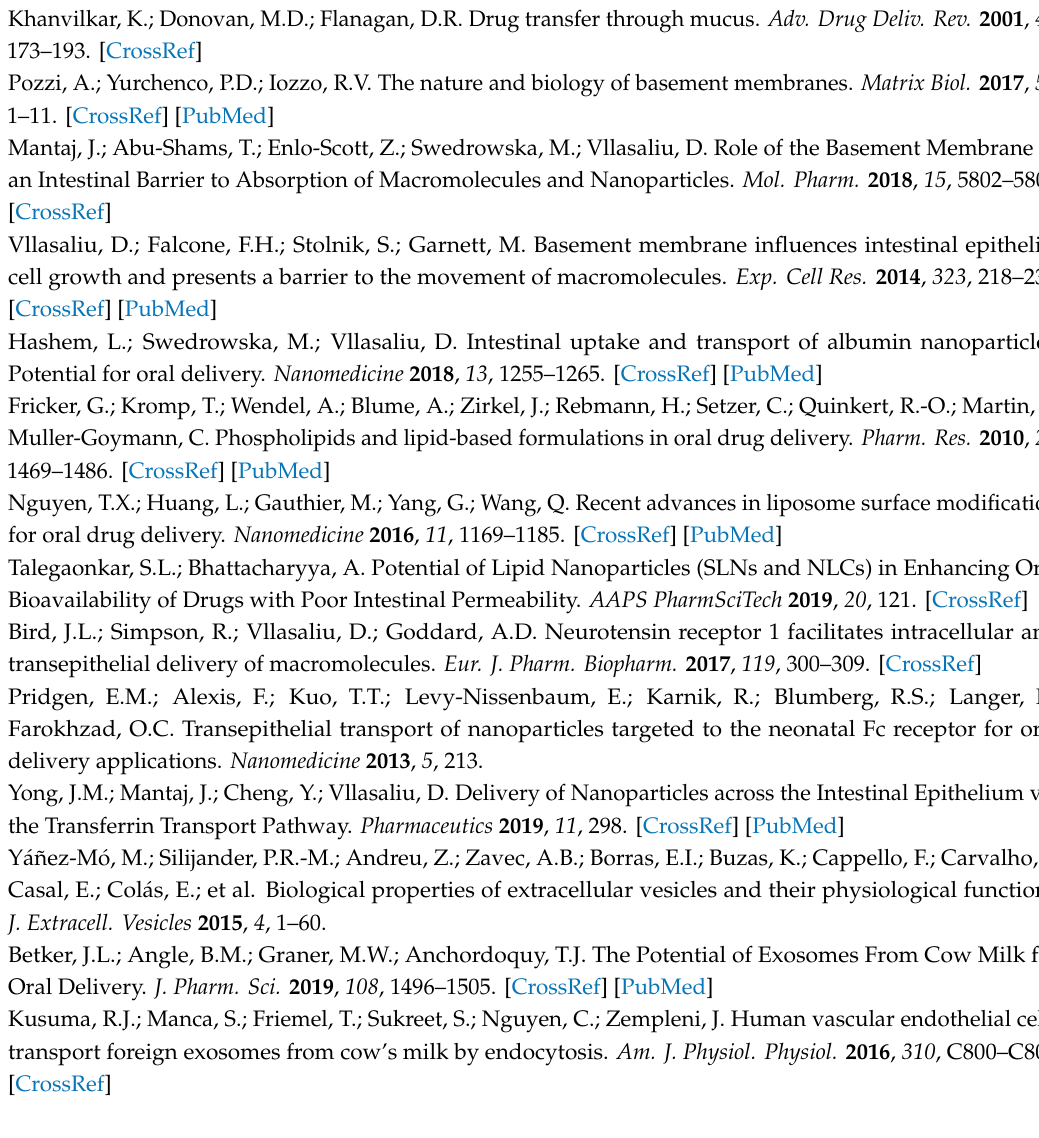
Figure S1: Size exclusion chromatography profiles, Table S1: Hydrodynamic size, polydispersity index and zeta potential of